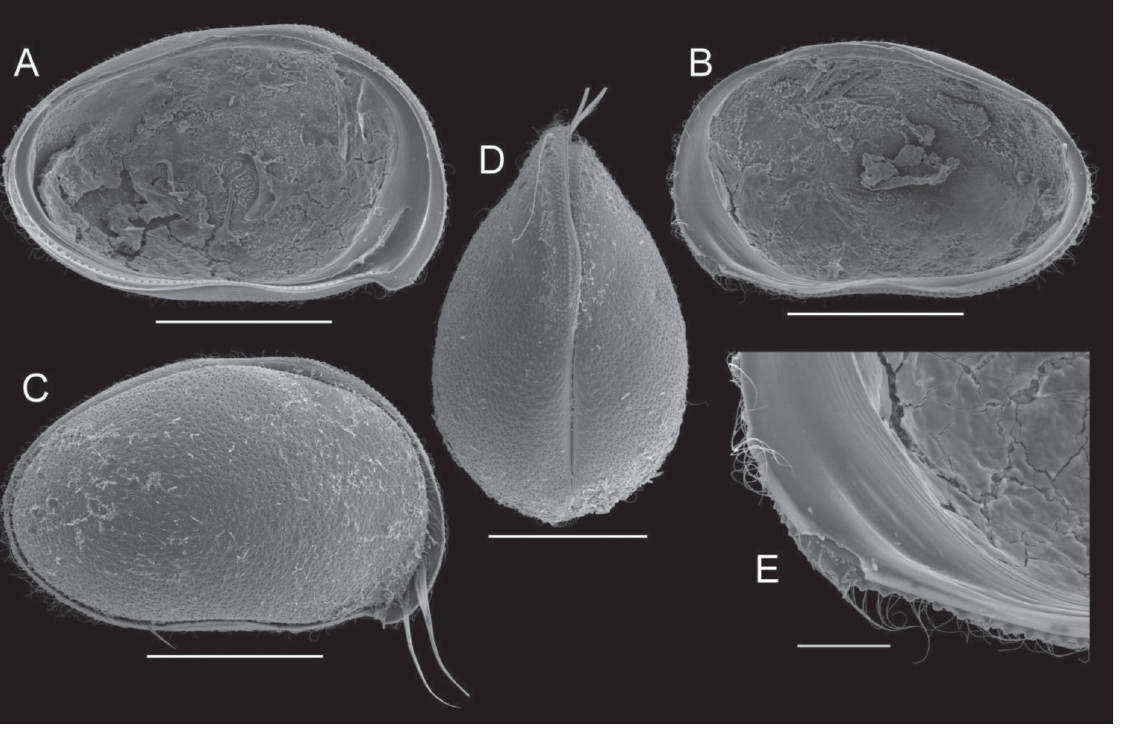
Fig. 11. Bennelongia harpago De Deckker & Mckenzie, 1981, all from Lake Powlathanga, QLD. A . ♀, LVi (W40014). B . ♀, RVi (W40014). C . ♀, CpRl (W40015). D . ♀, Cp dorsal (RS35). E . ♀, RVi detail anteriorly (W40014). Scales: A-D = 500 μm, E = 100